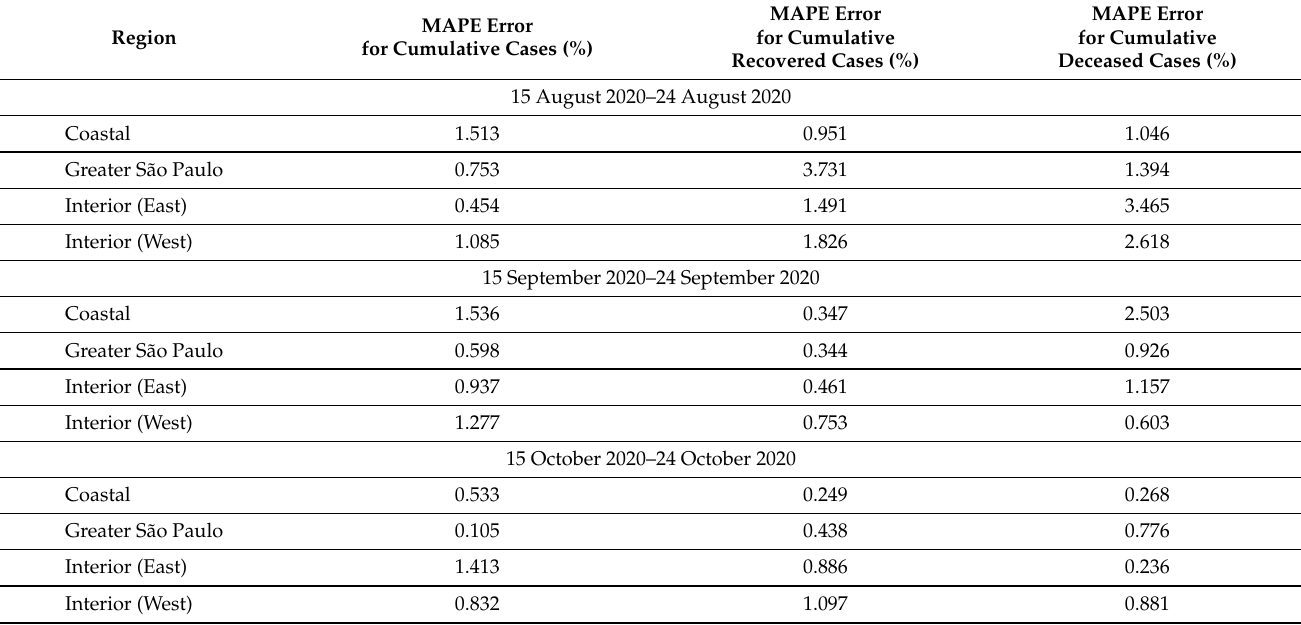
Table 3. MAPE errors for different forecasting periods.